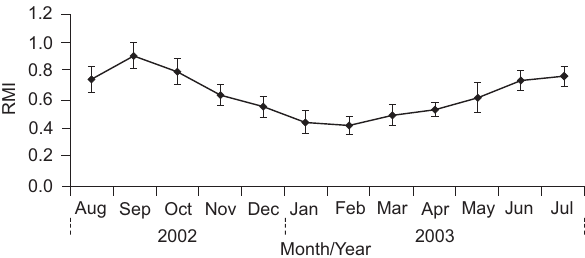
Figure 4. Monthly average (mean ± standard error; SE) of relative marginal increment (RMI) in otoliths of C. edentulus in the Saco dos Limões bight (southern Brazil).